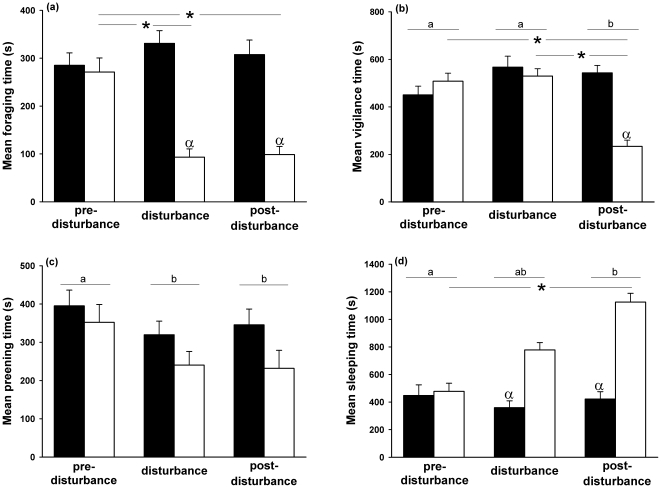
Time budget in tufted ducks.(a) Foraging, (b) vigilance, (c) preening and (d) sleeping behaviours for the week before the disturbance, the week of disturbance and the week after the disturbance for the control group (black bar) and group 2 (white bar) for each observation week. Letters indicated significant differences between weeks. *Indicates significant differences between weeks for a group or between two groups. α indicates that behaviour duration was significantly different for the control group compared to the disturbed group during the week of disturbance and the week after disturbance.